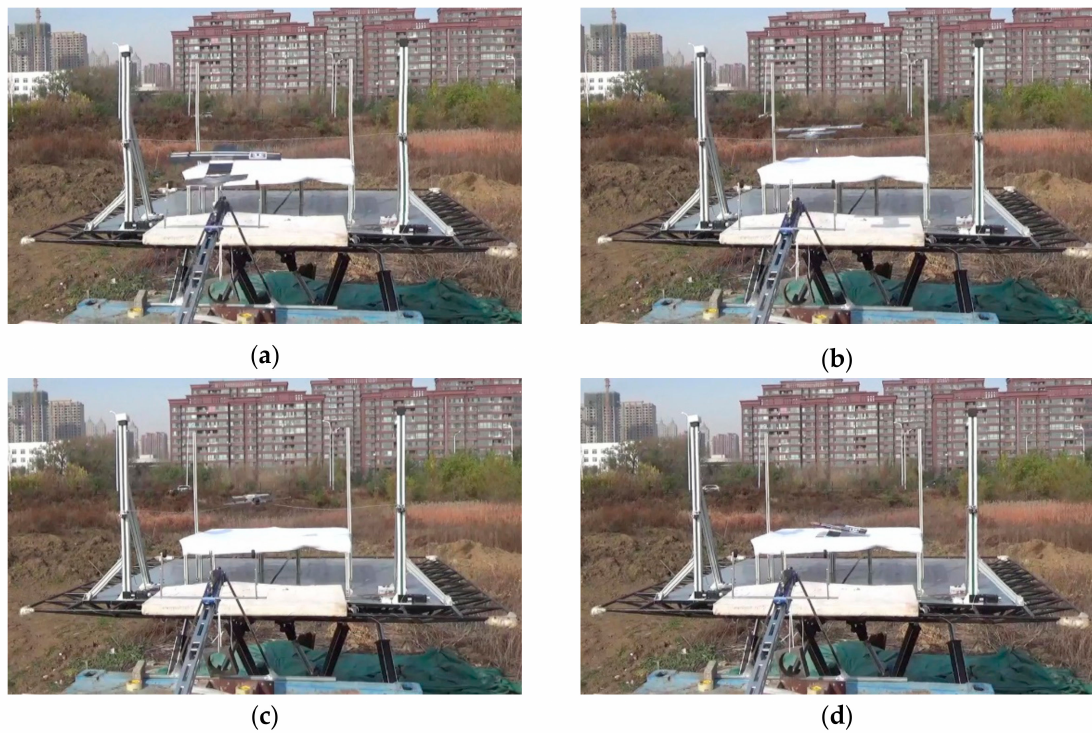
Figure 19. Autonomous recovery UAV experiment process. ( a ) UAV catapult takeo ff ; ( b ) UAV in flight; ( c ) hook up the arresting cable; ( d ) UAV speed drops rapidly and falls on the recovery